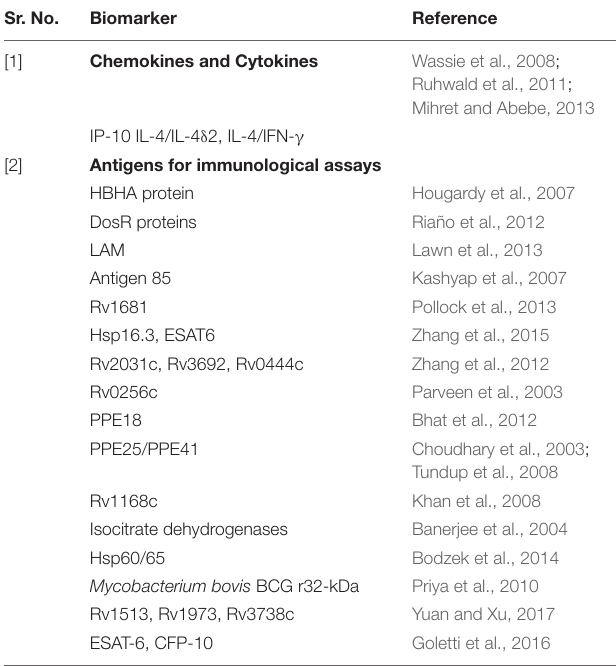
TABLE 2 | Diagnostic biomarkers against mycobacterial pathogens. Sr.